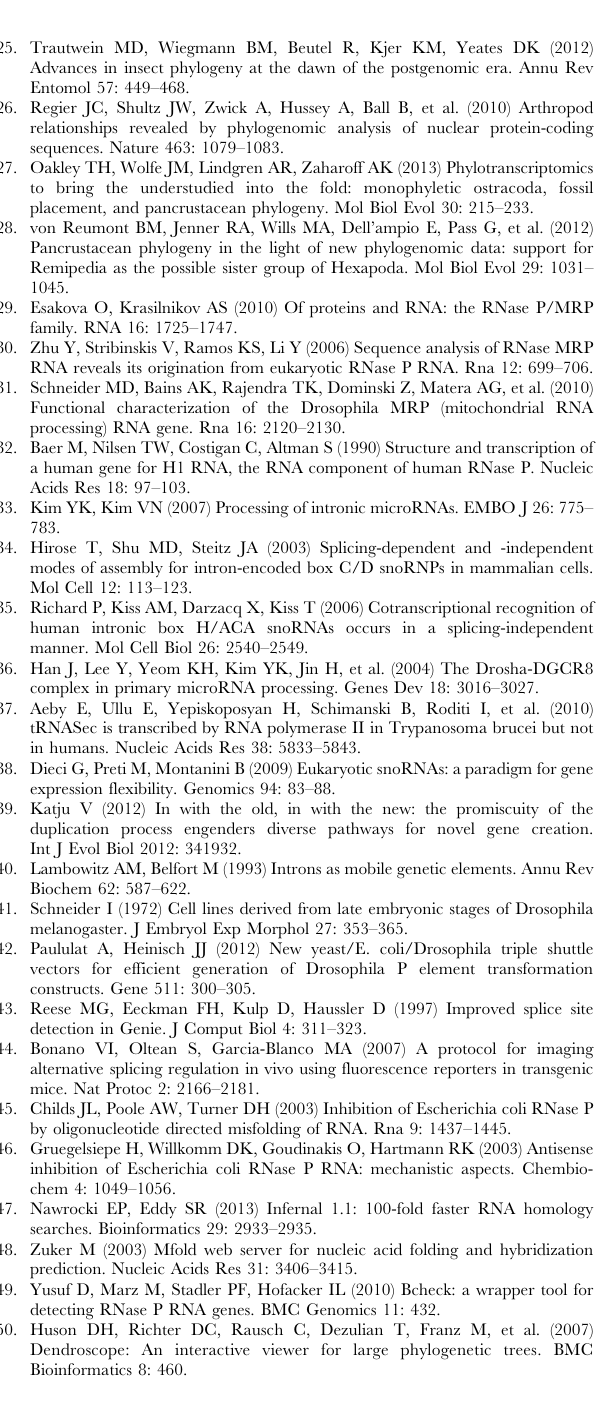
S3 Table. Genomic information for the T. castaneum recipient gene ( Mbs/PPP1R12B ), RPRs , and orthologs of recipient genes in other species. The gene IDs and the alternate IDs in Tcas3.22 (EMBL) identified by a TBLASTN search [61] are shown. Cufflinks was used to determine the locus and gene span [60]. Reference housekeeping genes are shown in